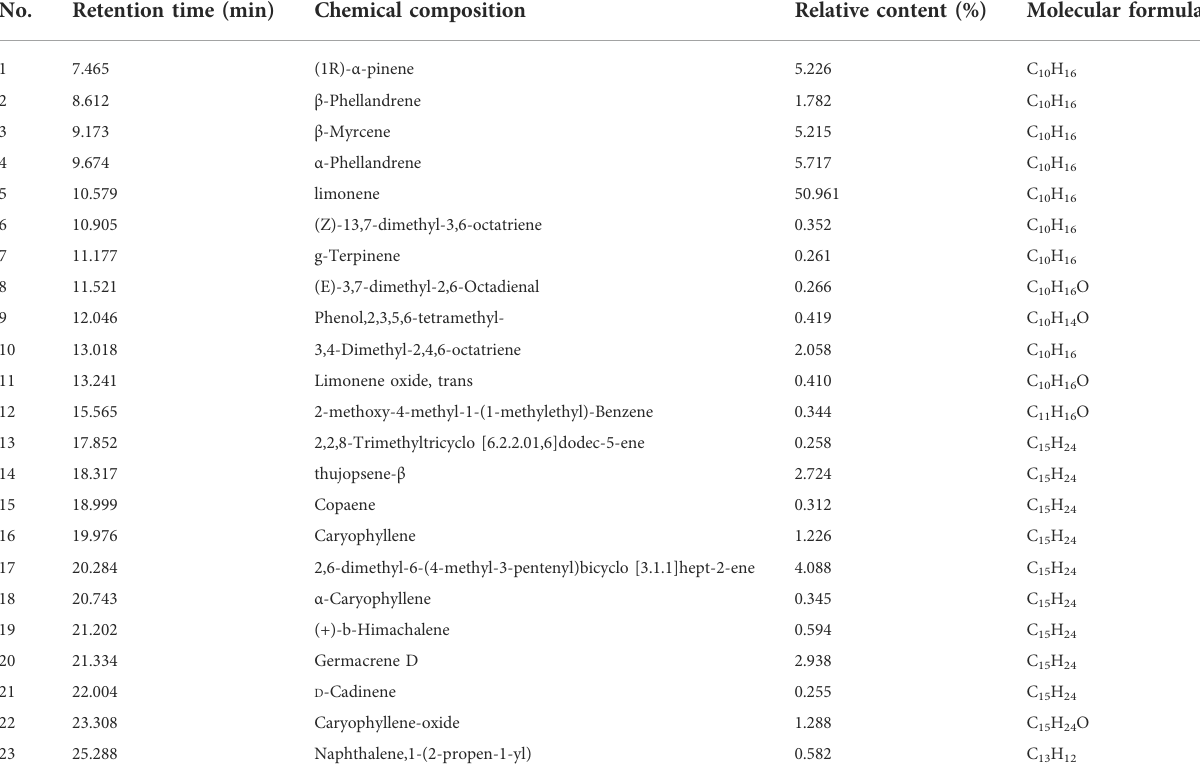
TABLE 1 Analysis of main components of